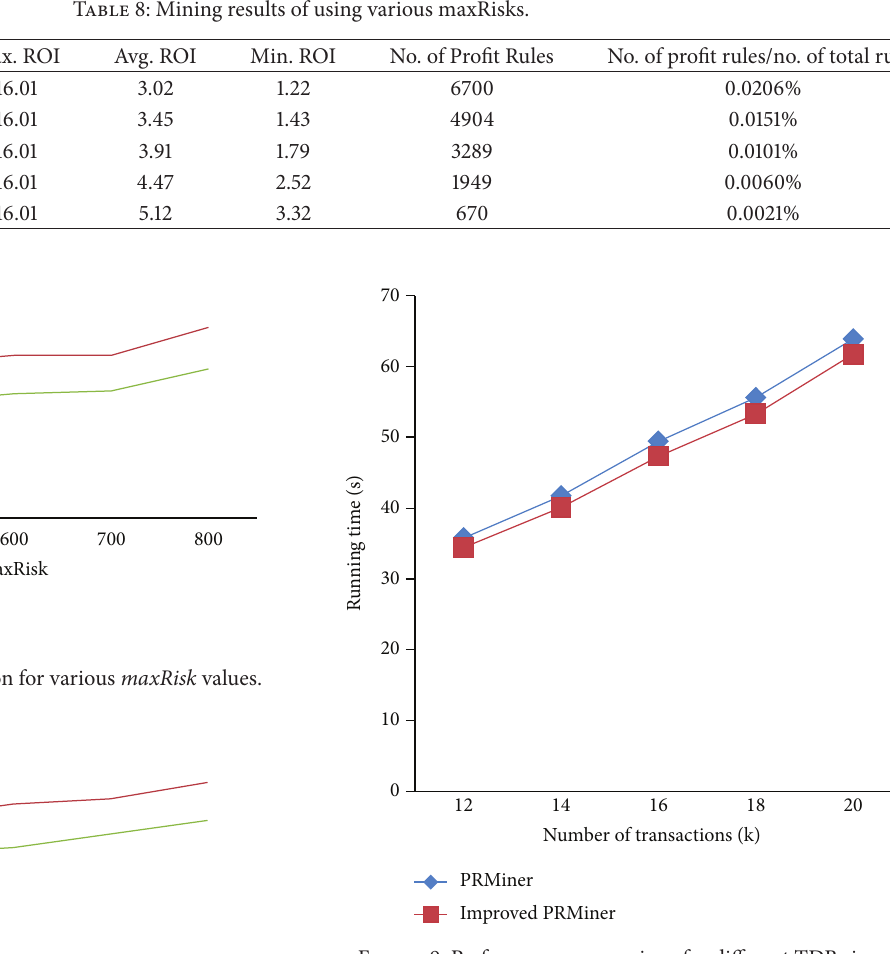
Figure 9: Performance comparison for different TDB